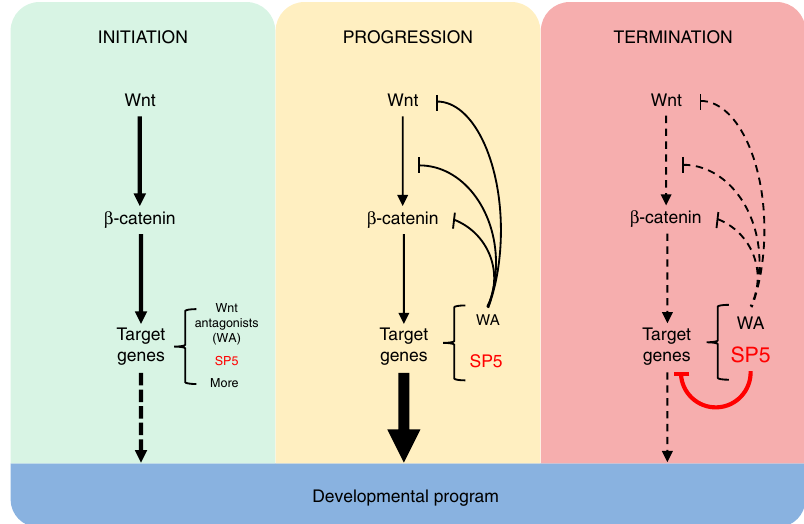
Fig. 6 Model for SP5 ’ s role in terminating a developmental program. WNT signaling is initiated when WNT engages its receptor encoded by FZD, leading to stabilization of β -catenin and subsequent activation of target gene expression. WNT target genes encode WNT antagonists (WA), which serve to downregulate the WNT signaling input as other target genes mediate the WNT effect on a developmental program. During this stage of signaling, SP5 protein accumulates and then competes with SP1 for binding at many WNT target gene sites. The net effect is that SP5 acts to diminish and terminate the transcriptional program previously activated by